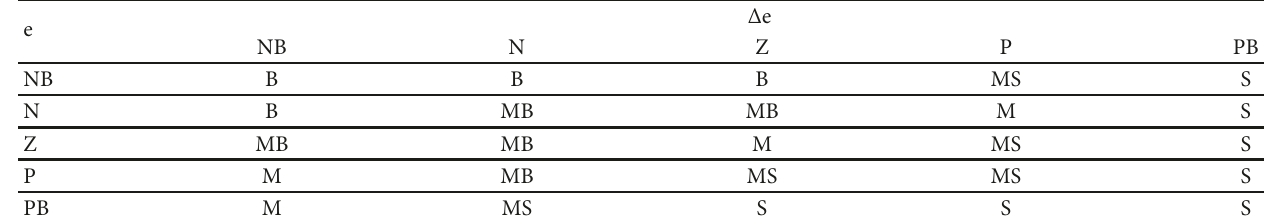
Table 3: Fuzzy rules of K I